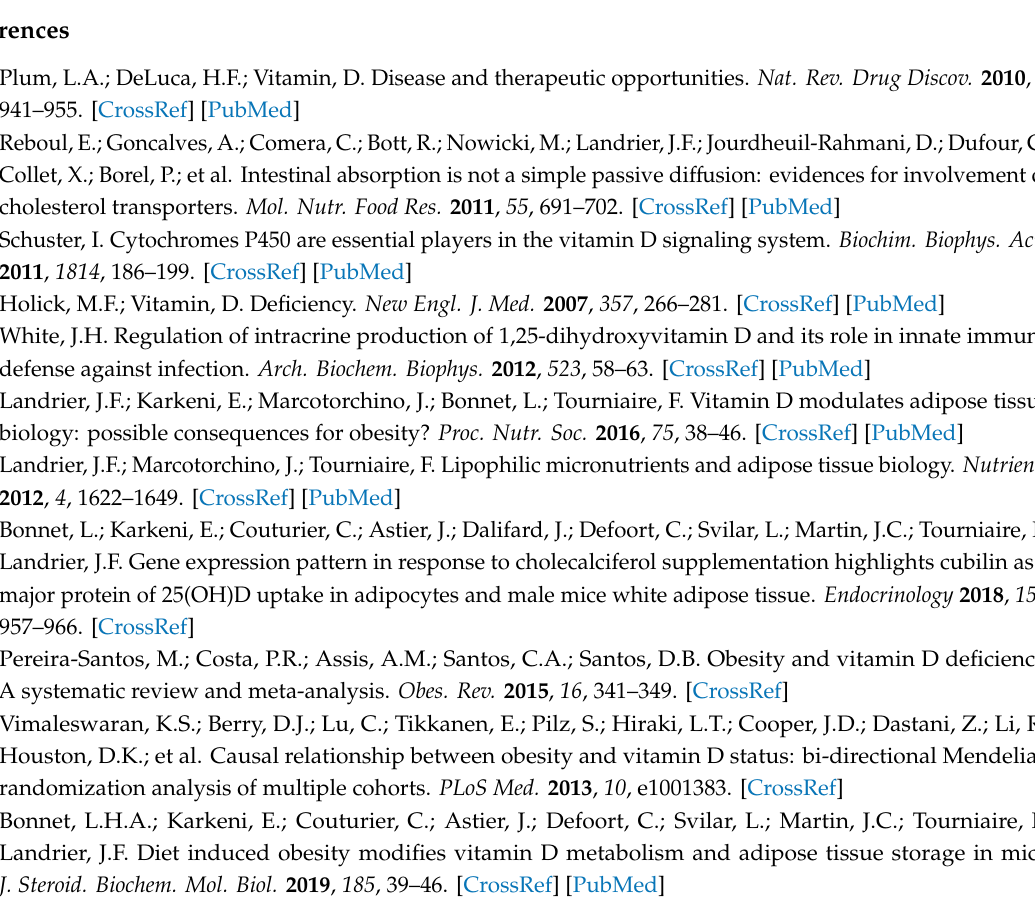
Figure S1: MS / MS spectrum of 1,25(OH)2D3, 25(OH)D3 and cholecalciferol derivatized with Amplifex reagent and their respective deuterated forms, Figure S2: Derivatization reaction, Figure S3: Extrated Ion Chromatography of plasma ( A ) and adipose tissue ( B ) sample derivatized with Amplifex reagent (a) m / z 657.43 extracted from the MS / MS spectrum of m / z 716.50 ion of cholecalciferol-Amplifex, (b) m / z 660.45 extracted from the MS / MS spectrum of m / z 719.50 ion of d3-cholecalciferol-Amplifex, (c) m / z 673.43 extracted from MS / MS spectrum of m / z 732.51 ion of 25(OH)D3-Amplifex, (d) m / z 676.45 extracted from MS / MS spectrum of m / z 735.50 ion of d3-25(OH)D3-Amplifex, (e) m / z 689.43 extracted from MS / MS spectrum of m / z 748.51 ion of 1,25(OH)2D3-Amplifex and (f) m / z 692.44 extracted from MS / MS spectrum of m / z 751.50 ion of d3-1,25(OH)2D3-Amplifex, Table S1: Experimental diet compositions, Table S2: Mice morphologic parameters, Table S3: Food intake